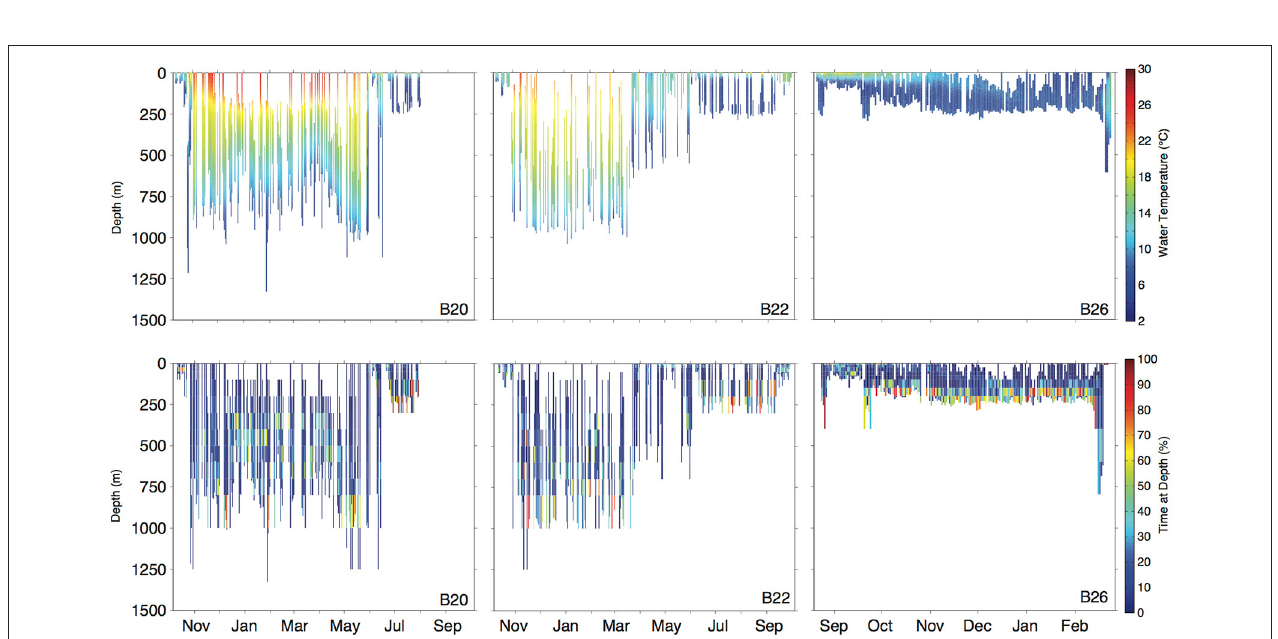
FIGURE 4 | Daily depth-temperature profiles (row 1) and time-at-depth profiles (row 2) for three representative basking sharks (tracks plotted in Figure 5A ). Note differing time scale (x-axis) among individuals.